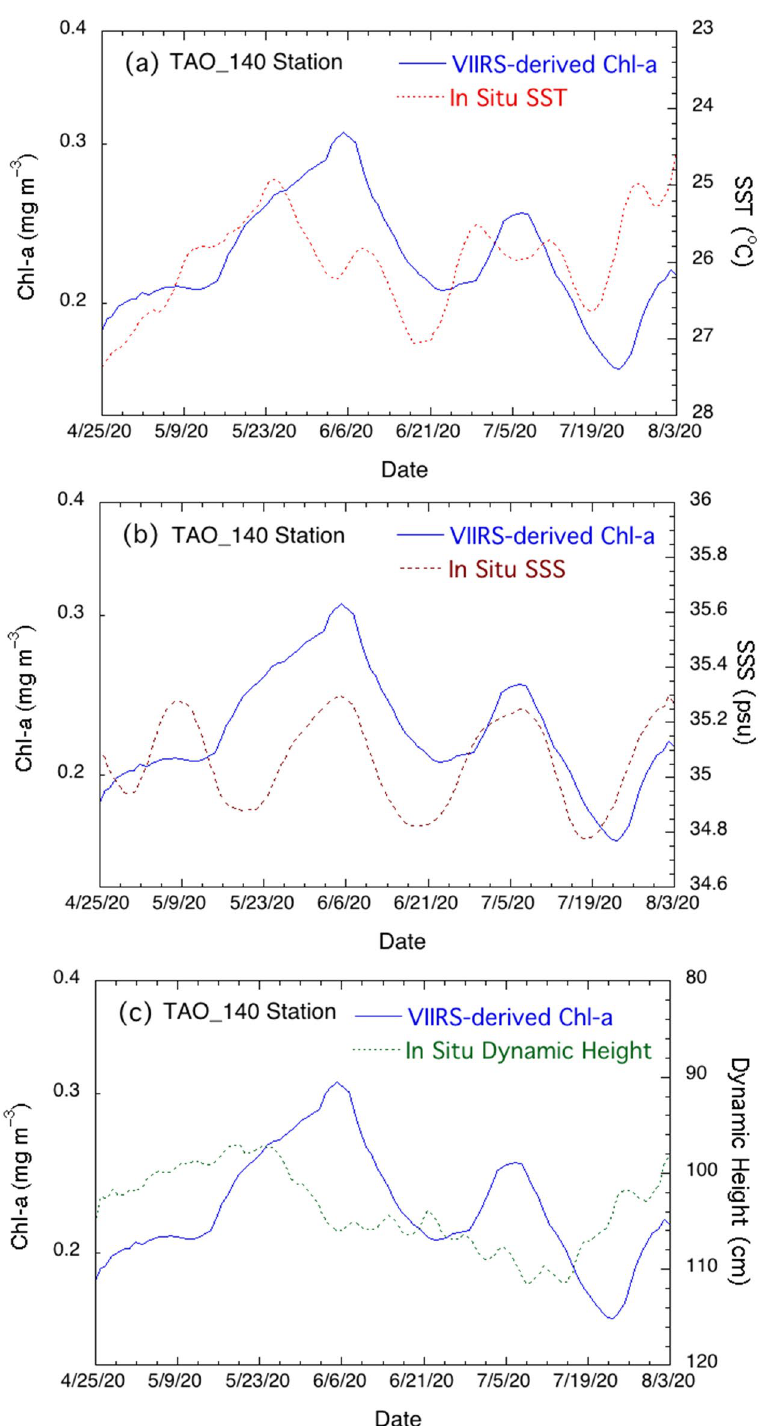
Figure 5. Temporal change of VIIRS-measured Chl-a in comparison with ( a ) in situ SST variation, ( b ) in situ SSS variation, and ( c ) dynamic height from April 25–August 3, 2020 at the TAO_140W station. Note the Chl-a, SST, SSS, and dynamic height are 5-day running mean values in order to remove the measurement noises of these parameters. The y-axis values (right side) for plots SST ( 5a ) and dynamic height ( 5c ) are scaled from high to low to show better comparisons of their variations with those of Chl-a (scaled